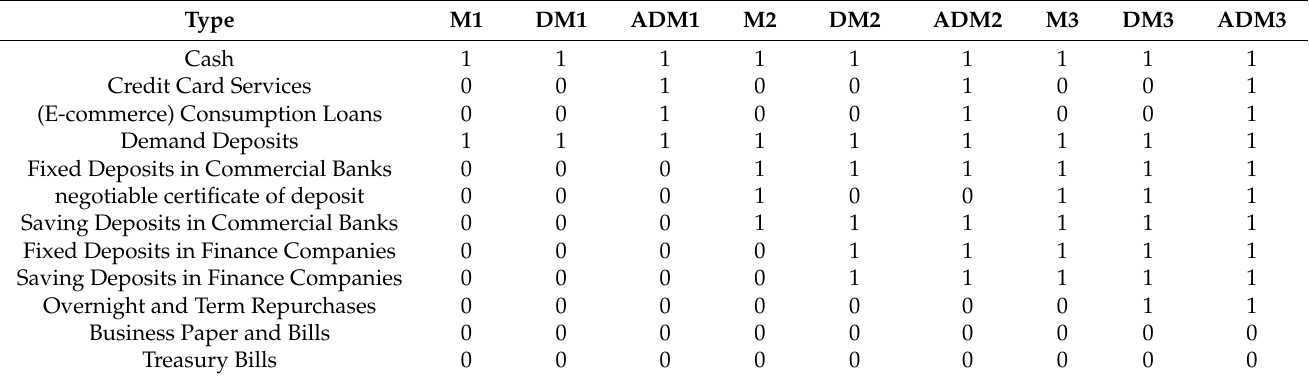
Table 1. Monetary Aggregation Categorization—Table of